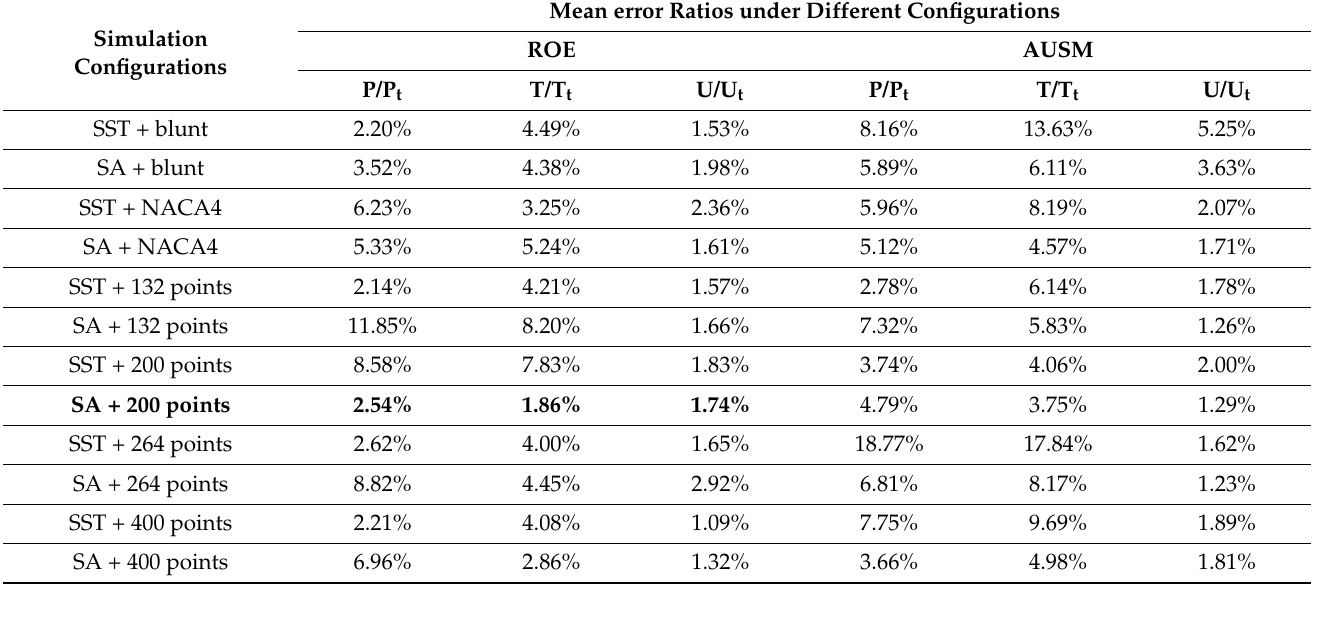
Table 19. The mean error ratios of P/P t , T/T t , and U/U t of the 16 m far-field distance.